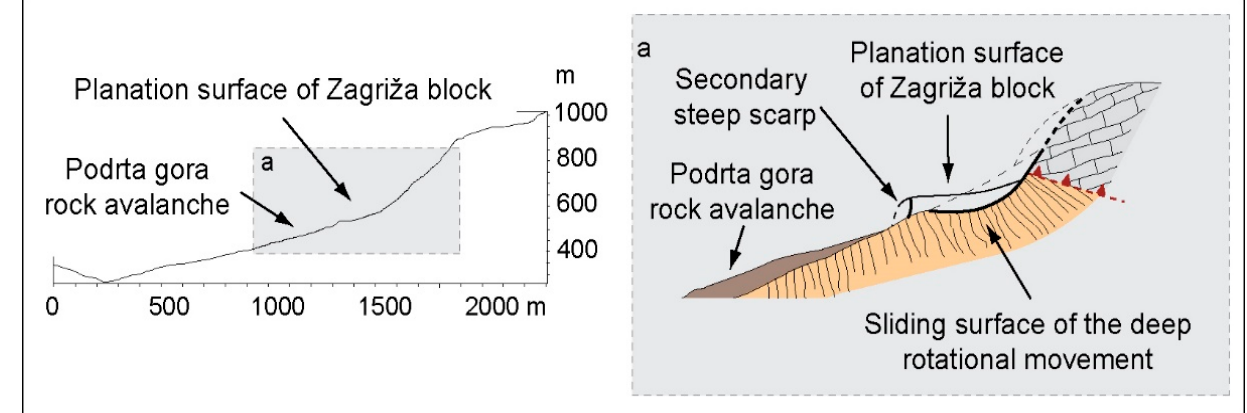
Figure 6. Rotational Zagriža carbonate block, which is part of the complex two-phase Podrta gora rock avalanche. The detail of rotational Zagriža carbonate block is on the right side of the image (area a).